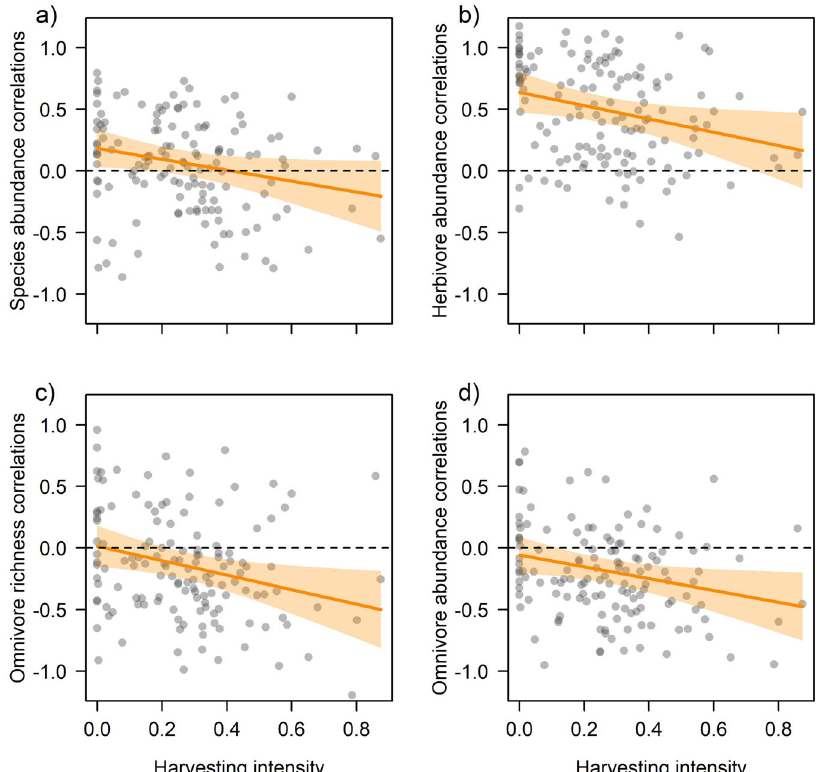
Fig. 4 Results for site-level correlations and harvesting intensity. Harvesting intensity before the start of insect sampling was related to site-level correlations (each shown as partial residuals of Pearson ’ s r between year and the respective community response) in insect populations, with sites characterized by higher harvesting having more negative (or less positive) correlations in a total insect abundance. The relationship with harvesting intensity prevailed across trophic groups as indicated for b herbivore abundance, c omnivore species richness, and d omnivore abundance. Note that even for b herbivores, which had positive correlations with time, abundance correlations on sites with more harvesting were lower. Full statistical details are available in Supplementary Data 1. Regression lines (95% CI in shaded polygons) indicate the marginal predictions of linear mixed-effects models. Dashed horizontal lines mark null with negative values indicating sites with declining and positive values sites with increasing community responses over